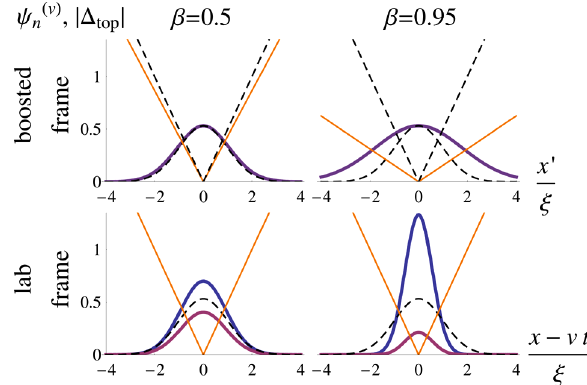
FIG. 4. Majorana wave functions in lab and comoving refer- ence frames, for different velocities as shown in the figure. The solid blue and red graphs show the first and second components of the Majorana wave function in the low-energy subspace. The solid orange line plots the absolute value of j (cid:2) shows the relativistic renormalization of length scales in the comoving frame. The Majorana wave function and the topologi- cal gap for a static domain wall are shown for comparison (dashed lines).